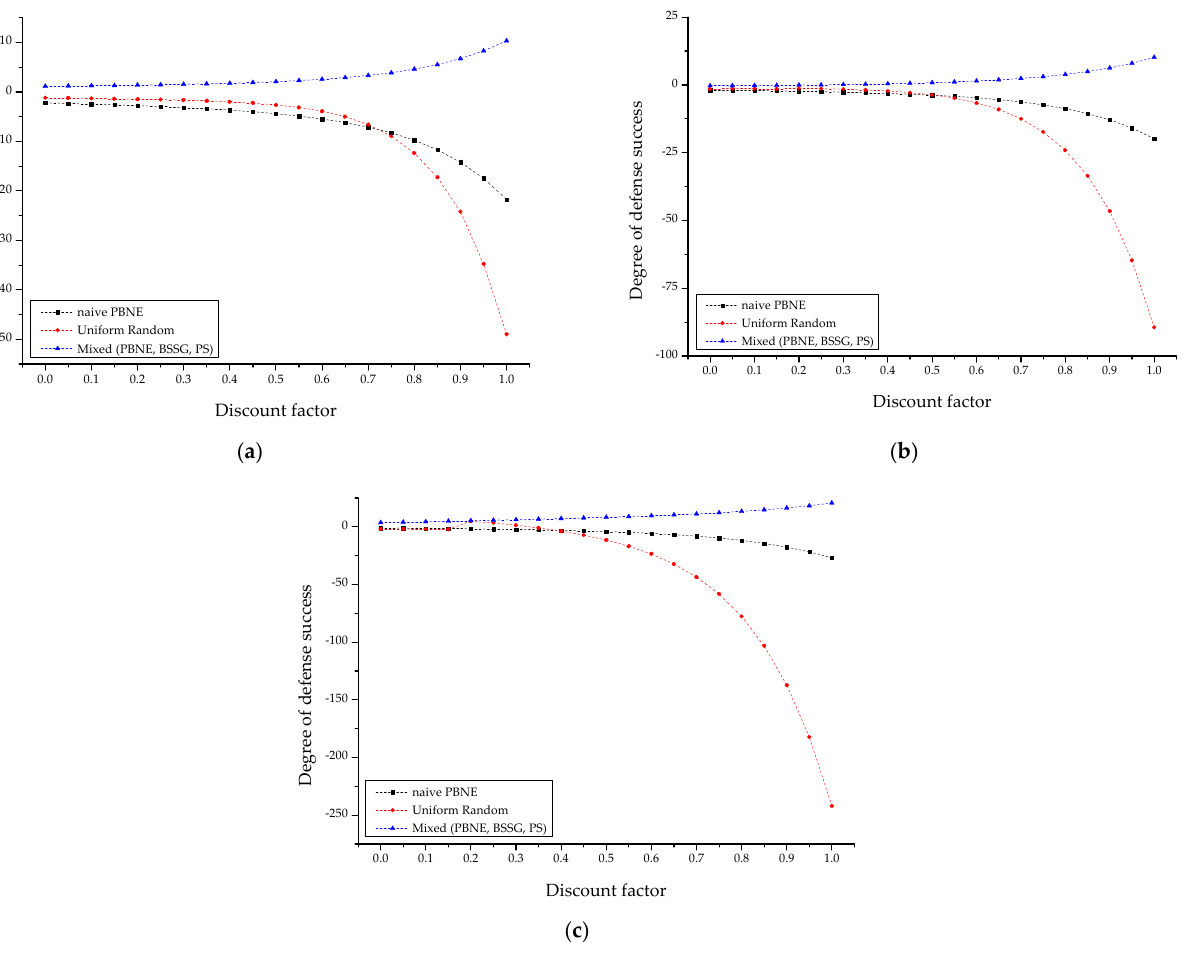
Figure 10. Comparison of the attack success probability in each state with Scenario 3. ( a ) S 1 , ( b ) S 2 , and ( c ) S 3